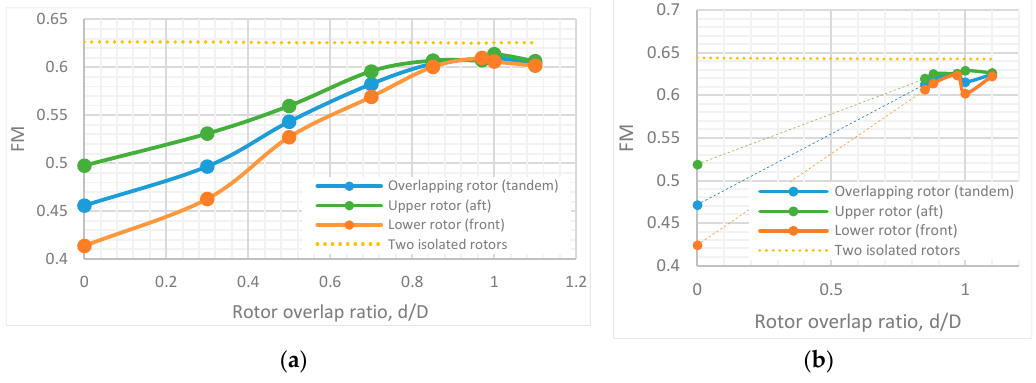
Figure 17 . Overlapping rotor (tandem) performance in terms of FM as a function of the overlap ratio (z/D = 0.05): ( a ) overall thrust = 8 N; and ( b ) overall thrust = 15 N.